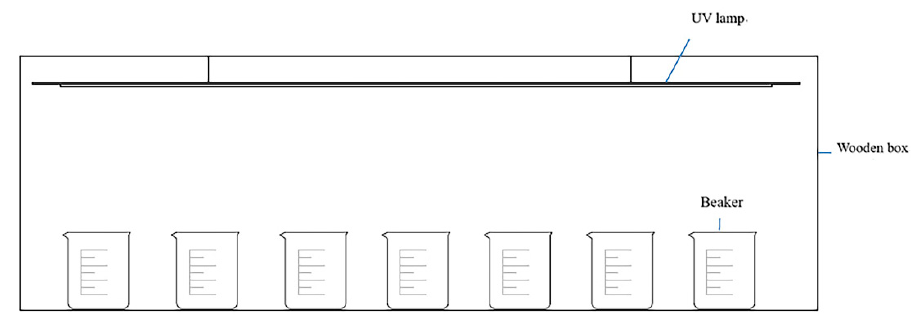
Figure 1. Device design for photocatalytic experiments.